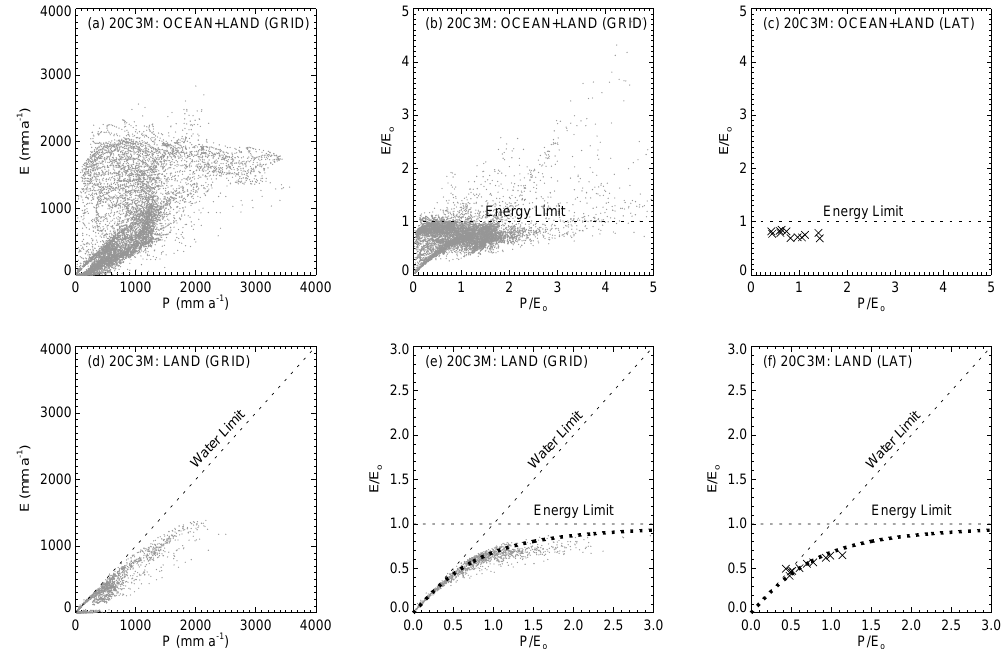
Fig. 2. Relation between mean annual P and E over the (top panels) globe (land plus ocean) and over (bottom panels) land. All climate model output are for the end of the 20th century (1970–1999). Model output for (a) P , E at individual grid boxes (b) normalised by the net irradiance ( E o ), and (c) averaged over 10 ◦ latitudinal zones. (d) , (e) , (f) Equivalent plots restricted to the land component. The energy ( E/E o =1) and water ( E ≤ P ) limits are discussed in the main text. The dotted curve in (e) and (f) is the predicted Budyko curve (Eq. (1)) with the default value of the parameter ( n =1.8, Choudhury, 1999). (Note: in e a better fit is obtained using n =1.5 but adopting that value does not materially change the subsequent results or